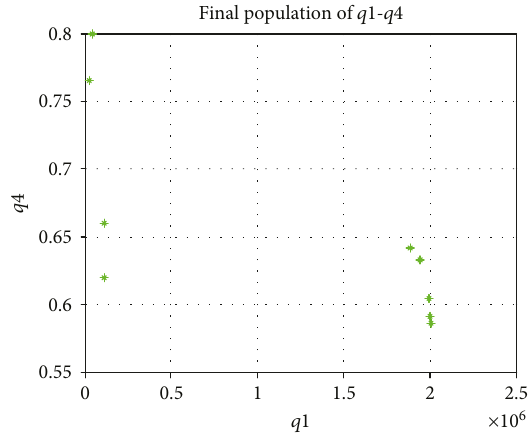
Figure 10: The fi nal population of MOEA/D.